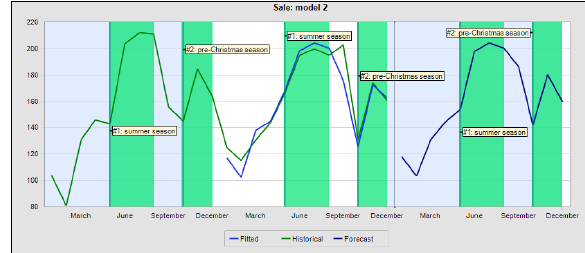
Figure 5: Forecast diagram of variable sale with marked events: model 2.